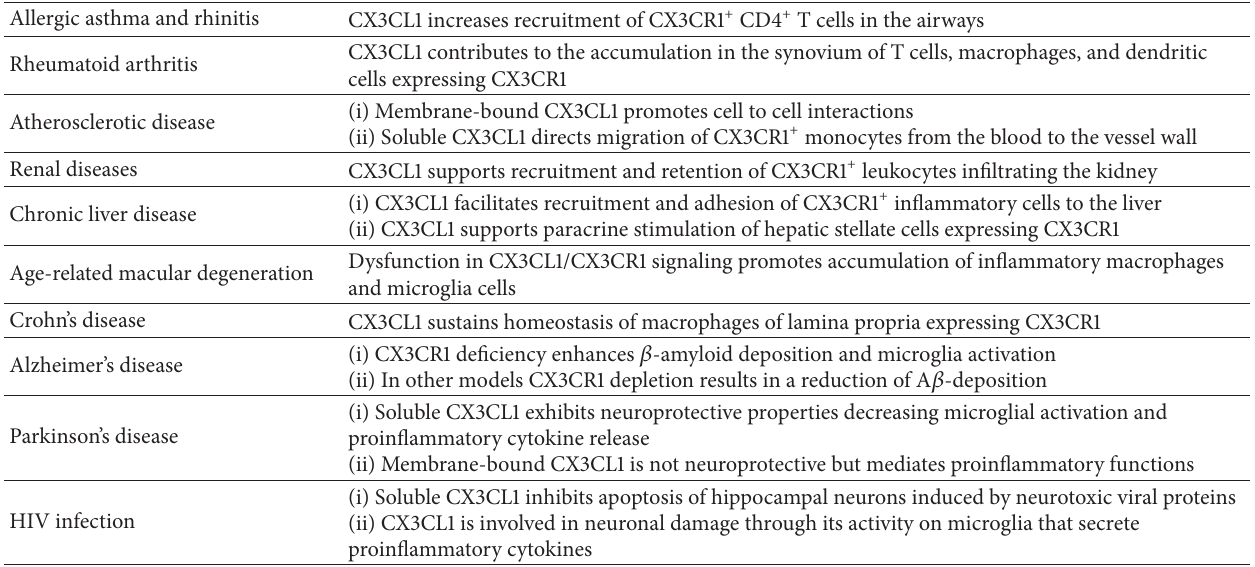
Table 1: Role of CX3CL1/CX3CR1 axis in inflammation and neurodegenerative diseases.